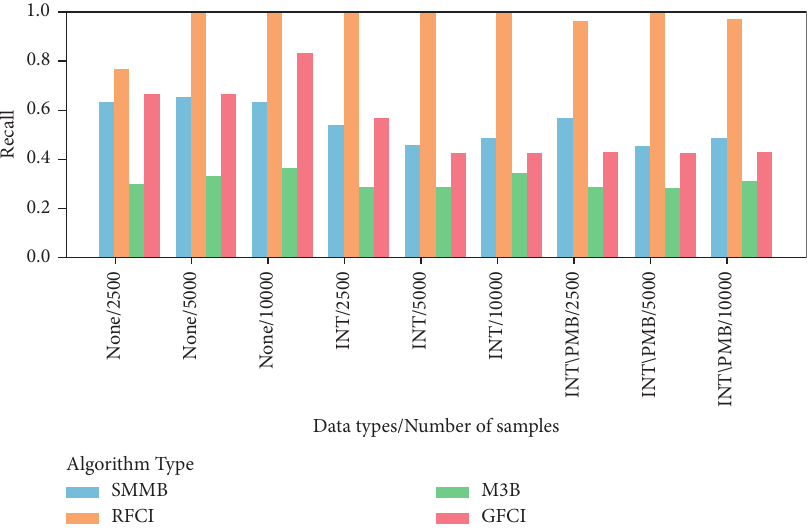
Figure 5: Comparison of SMMB, RFCI, M3B, and GFCI in recall.